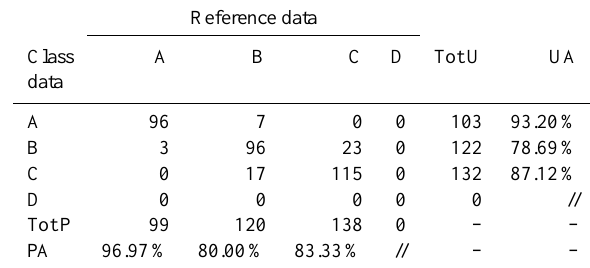
Table 4. Confusion matrix for the radial basis function network classifier evaluated on the overall test set TeS (cid:127) ; Class A: absence of snow cover, Class B: 1–10cm, Class C: 11–90cm, Class D: greater than 90cm.